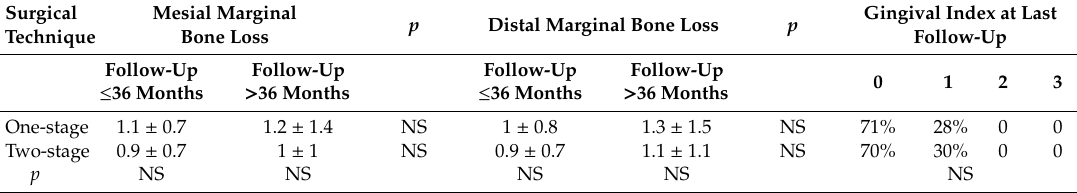
Table 2. Comparison of average marginal bone loss and gingival index between the two groups.